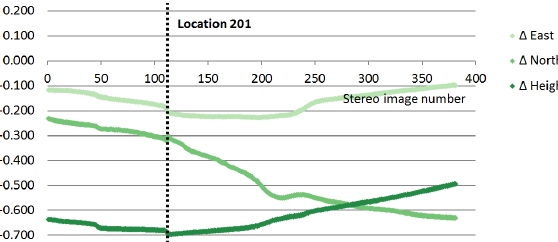
Figure 11. Deviations of projection centers for sequence 2.2